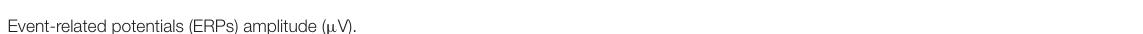
TABLE 1 | Event-related potentials (ERPs) amplitude ( µ V). ERPs component State